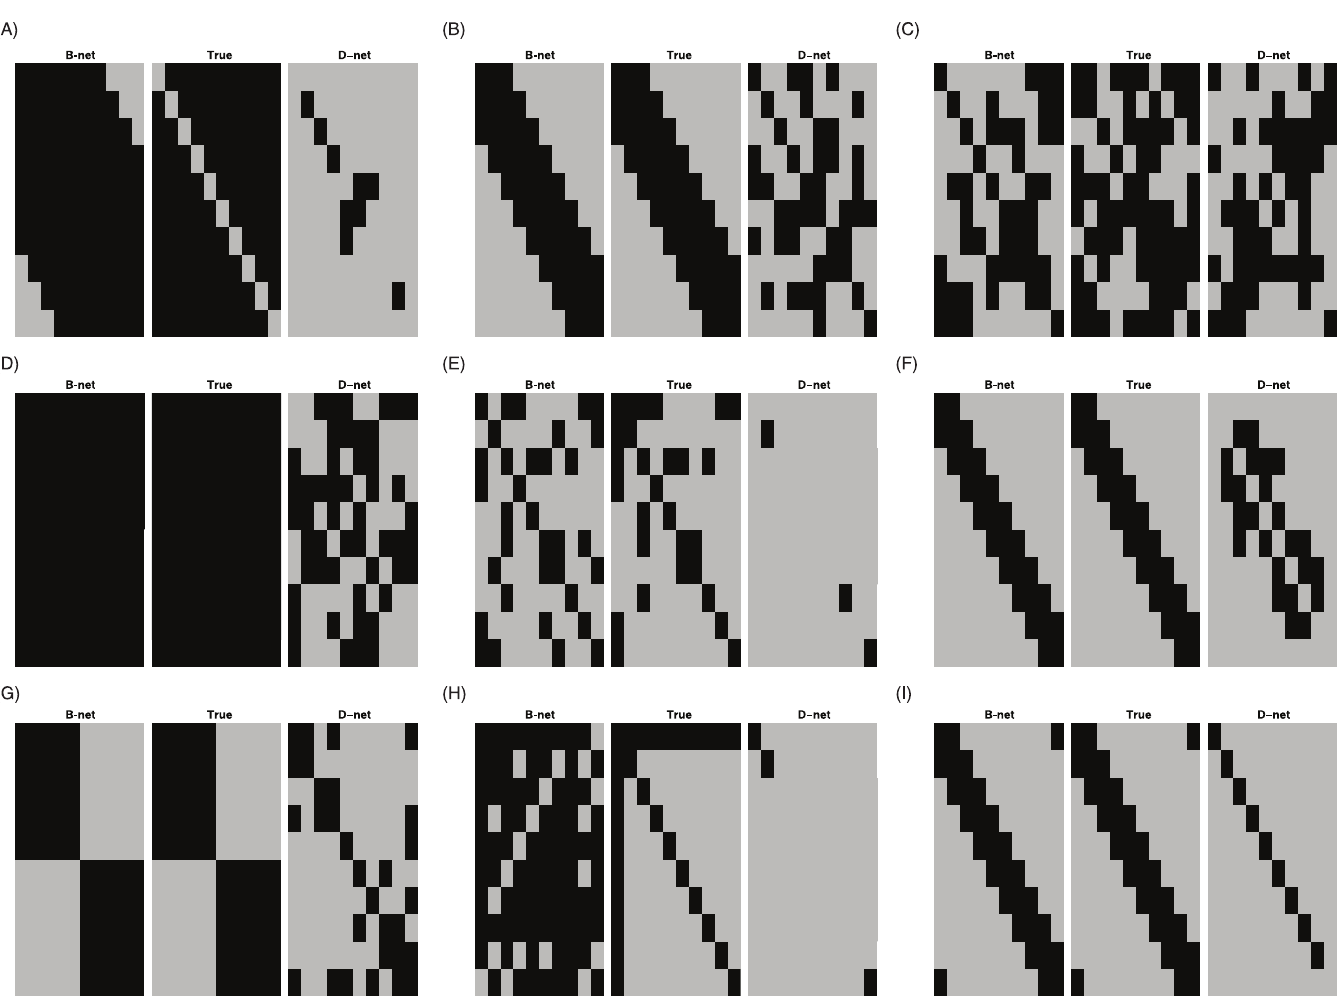
Fig 2. DN adjacency matrix heatmaps. Comparison of the true DN, B-net and D-net adjacency matrices for an AR(1), AR(2), sparse random, scale-free, band, cluster, star and circle graphical model and p = 10. (a) Model 1: AR(1). (b) Model 2: AR(2). (c) Model 3: at most 80% sparse. (d) Model 4: at most 40% sparse. (e) Model 5: scale- free. (f) Model 6: band. (g) Model 7: cluster. (h) Model 8: star. (f) Model 9: